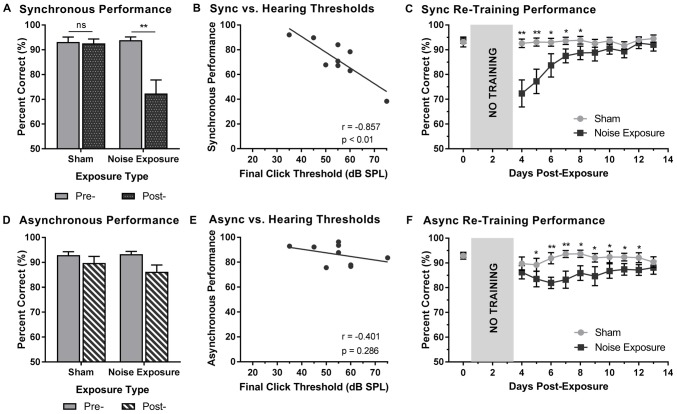
Hearing loss impaired performance during SJ training sessions. Performance on (A) synchronous and (D) asynchronous trials was compared pre- and 3 days post- exposure to a loud noise or sham. Following noise exposure, a significant decrease in performance on synchronous trials was observed (**p < 0.02, ns = not significant). No difference was observed on asynchronous trials. Solid bars represent pre-exposure performance and patterned bars represent post-exposure performance. Correlation results for (B) synchrony performance and (E) asynchrony performance were plotted as a function of final hearing sensitivity (i.e., click thresholds). Gray circles represent the individual data for each rat post-noise exposure. The solid line represents the linear regression line, and the Pearson correlation results along with the significance levels are displayed in the bottom of the panel. Behavioral performance on (C) synchronous and (F) asynchronous trials were monitored for 10 days following sham and noise exposure. Performance on synchronous trials returned to typical performance within 5 days, whereas performance on asynchronous trials remained consistently impaired across the majority of the training days (*p < 0.05, **p < 0.004). Results are displayed as mean ± SEM, n = 9.